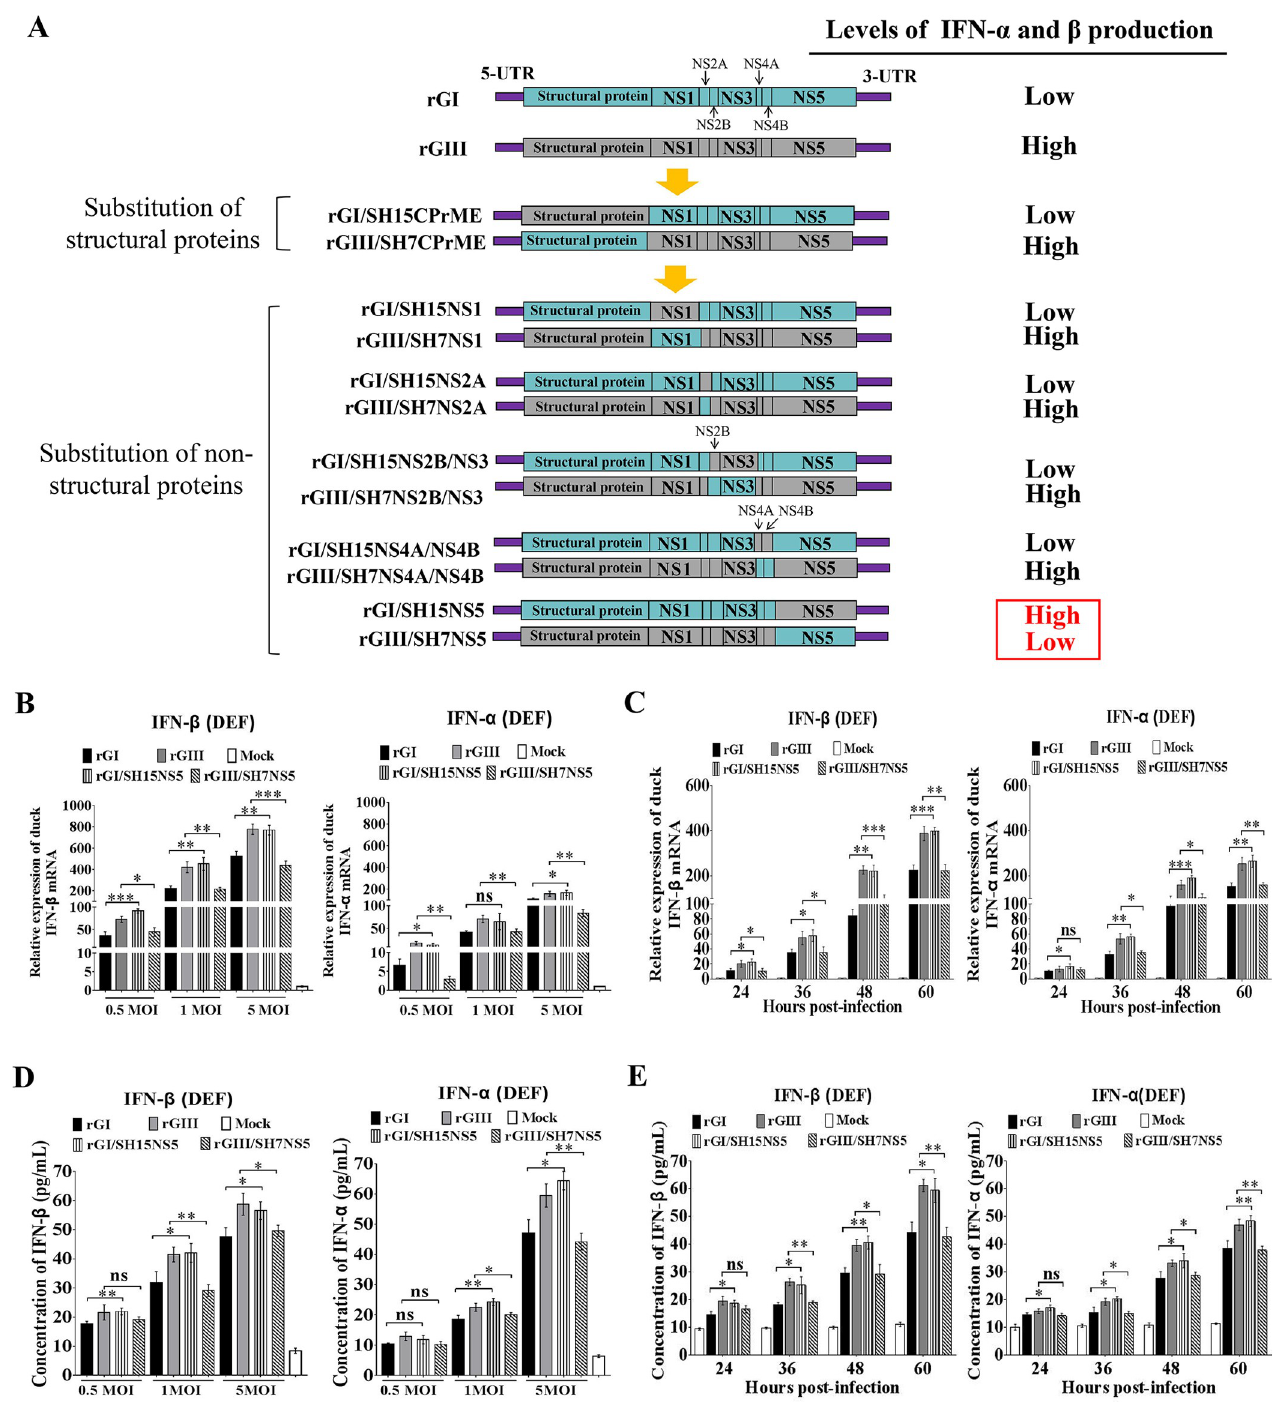
Fig 3. Identification of the viral determinant of different IFN- α and β induction. (A) Schematic diagram of parental and chimeric recombinant viruses used in this study. Viral proteins of GI and GIII strains are highlighted in blue and gray, respectively. (B and D) DEF were infected with the indicated recombinant viruses at a MOI of 0.5, 1, and 5 and harvested at 24 hpi for measurement of IFN- α and β production. (C and E) DEF were infected with the indicated recombinant viruses at 1 MOI and harvested at the indicated time points for measurement of IFN- α and β production. The mRNA levels of IFN- α and β in the cell pellets were examined by using qRT-PCR (B and C). The concentrations of IFN- α and β proteins in the supernatants were determined with ELISA (D and E). All data are presented as mean ± SD from three independent experiments. ��� , p < 0.001; �� , p < 0.01; � , p < 0.05; ns, no significant difference, by Student’s t -test.